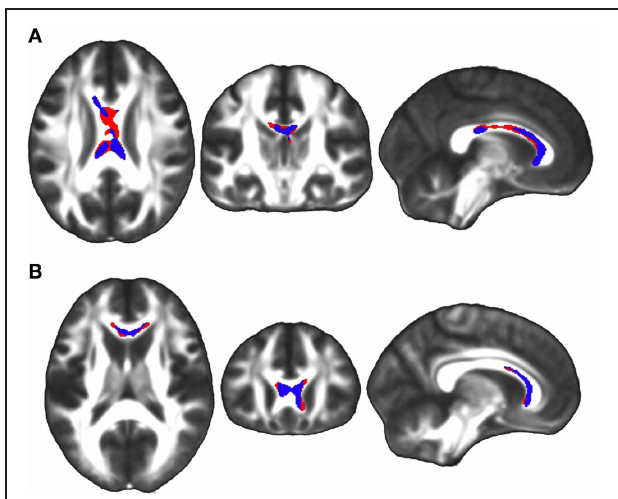
FIGURE 5 | (A) Simple effects analysis within the FA factorial model revealed a significant region of the corpus callosum in which TBI subjects